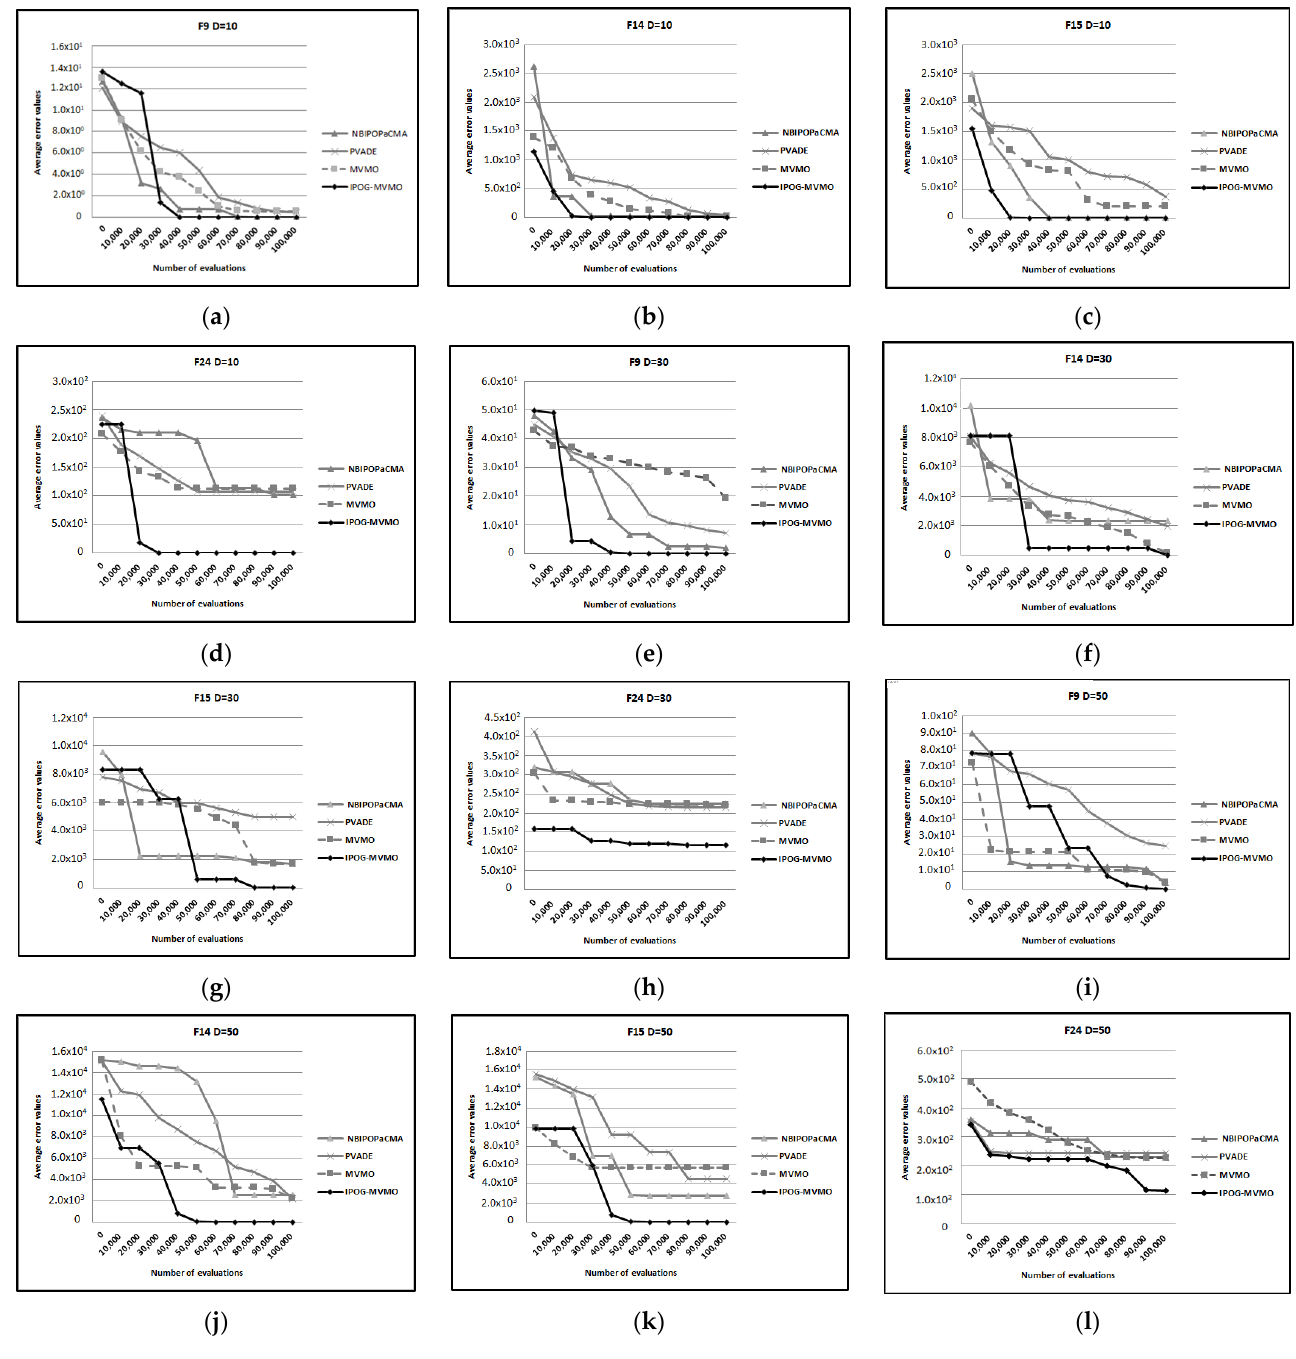
Figure 4. Examples of the performance comparison among IPOG-MVMO, NBIPOPaCMA, PVADE, and MVMO. F9, F14, F15, and F24 at 10, 30, and 50 dimensions were selected. The vertical axis represents the averaged error, while the horizontal axis represents the number of iterations. All were averaged over 50 trials. ( a – d ) F9, F14, F15, and F24 with 𝐷 = 10; ( e – h ) F9, F14, F15, and F24 with 𝐷 = 30; and ( i – l ) F9, F14, F15, and F24 with 𝐷 = 50, respectively.